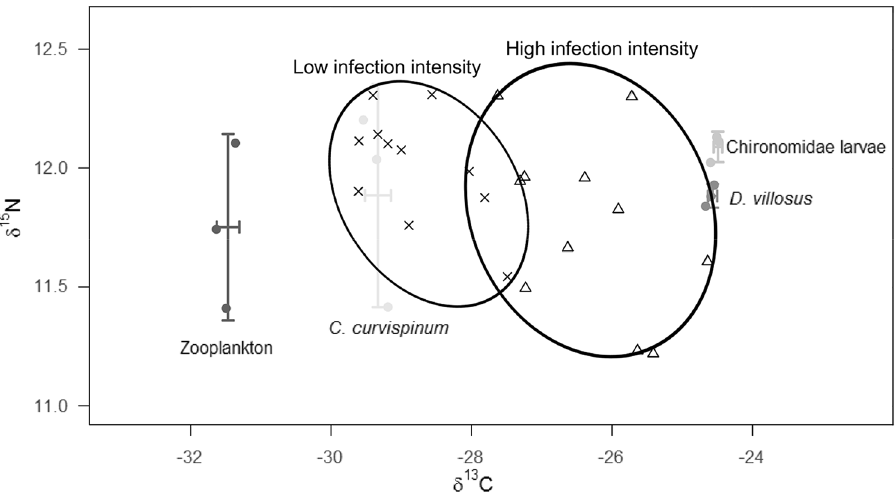
Figure 4. Stable isotope biplot of individual YOY perch ( Perca fluviatilis ) and their major prey categories sampled at the northern shore of Lake Müggelsee in 2016. Fish are divided in two categories based on eye fluke infection intensity: low infection intensity ( ×) = 5 ± 3 metacercariae per fish (average ± SD) and high infection intensity fish (Δ) = 39 ± 13 metacercariae per fish (average ± SD). Perch δ 13 C and δ 15 N signatures were corrected for fractionation by 1 ‰ and 3.5 ‰, respectively. Prey stable isotope signatures are shown as mean ± SD.